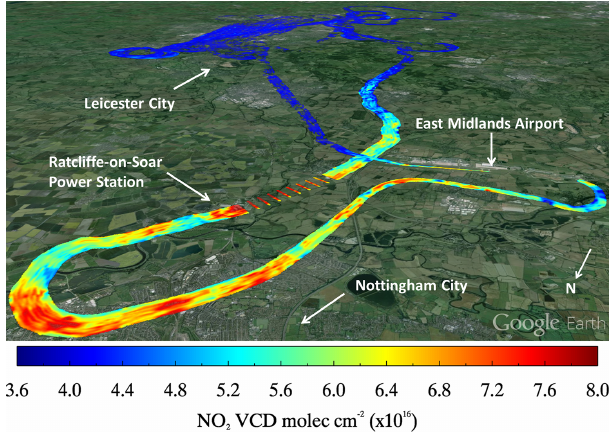
Figure 14. Google Earth overlay of NO 2 VCDs over Leicester and an area close to Ratcliffe-on-Soar power station and EMA. The colour scale is appropriate to discern structure within the area. The emissions from the power station are likely elevated having been emitted from a 200m high chimney. The gap in the data just prior to the power station is caused by the CompAQS spectrometer fail- ing for 46s. The single scans downwind of the power station are from the instrument temporarily stopping and starting because of an issue with the control